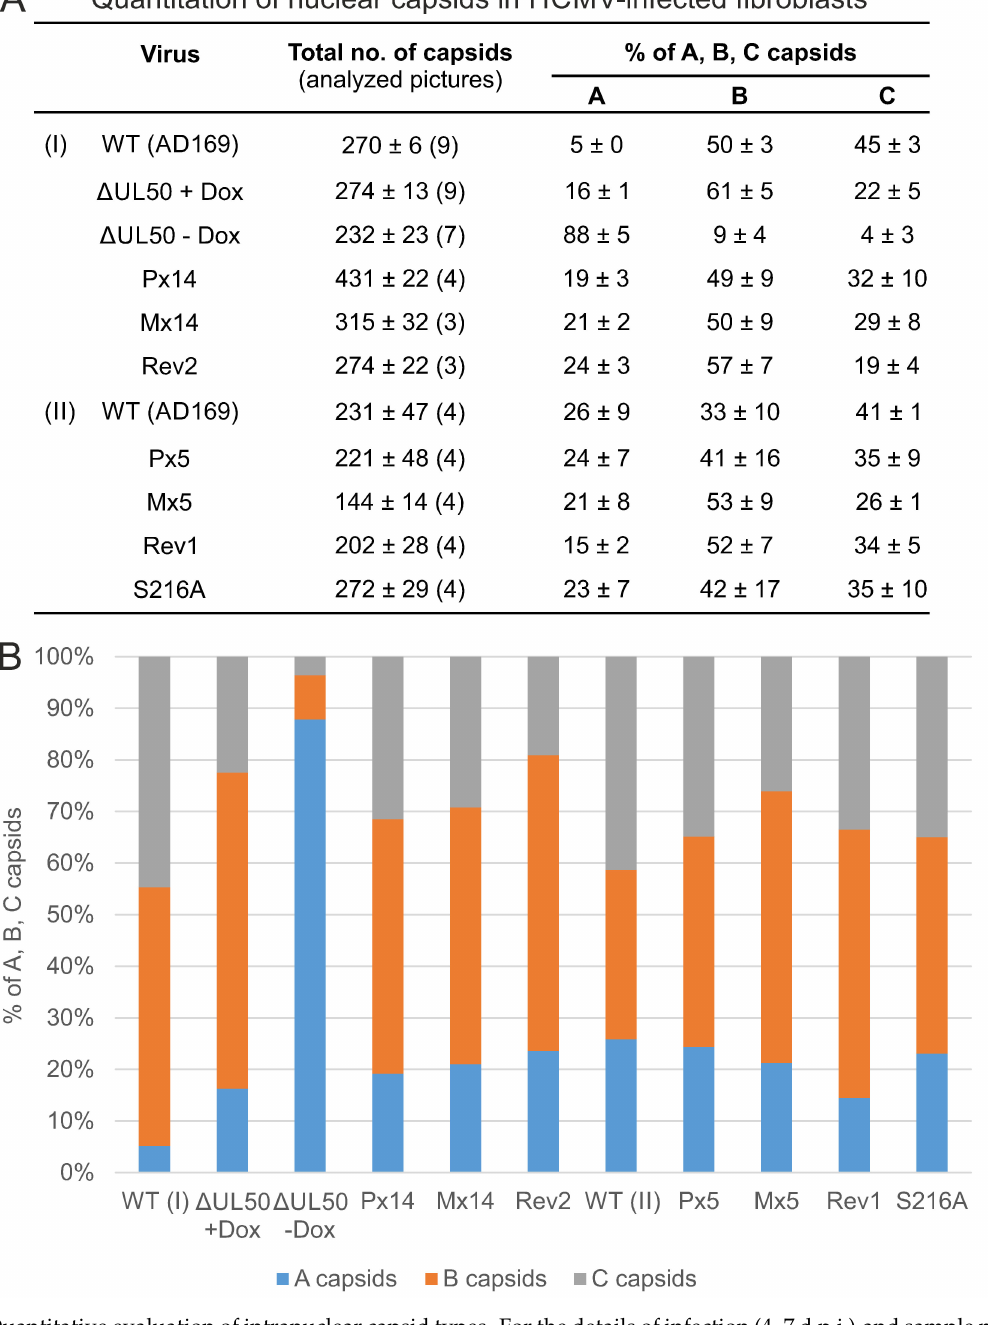
Figure 8. Quantitative evaluation of intranuclear capsid types. For the details of infection (4–7 d.p.i.) and sample preparation see Figure 7. ( A ) TEM counting was performed individually by researchers in duplicate ( n = 4–8), using up to nine nuclear sections for each virus. Mean values ± SD of A, B and C capsids are given, as set in percentage to the total number of capsids counted. ( B ) Diagram representation of the mean values given